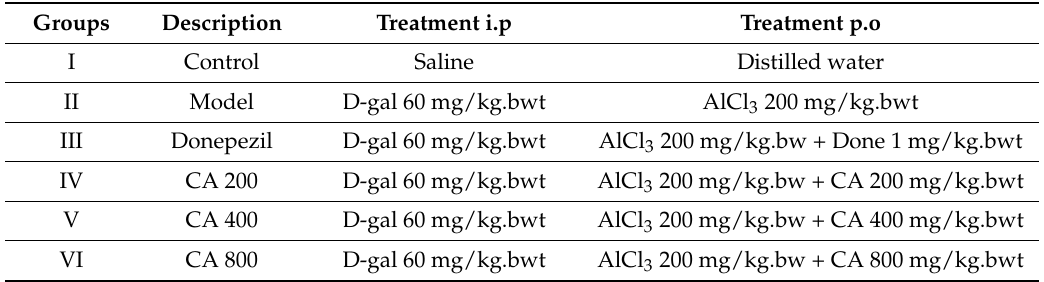
Table 1. AlCl3-, D-gal-, and Centella asiatica (CA)-treated groups and the